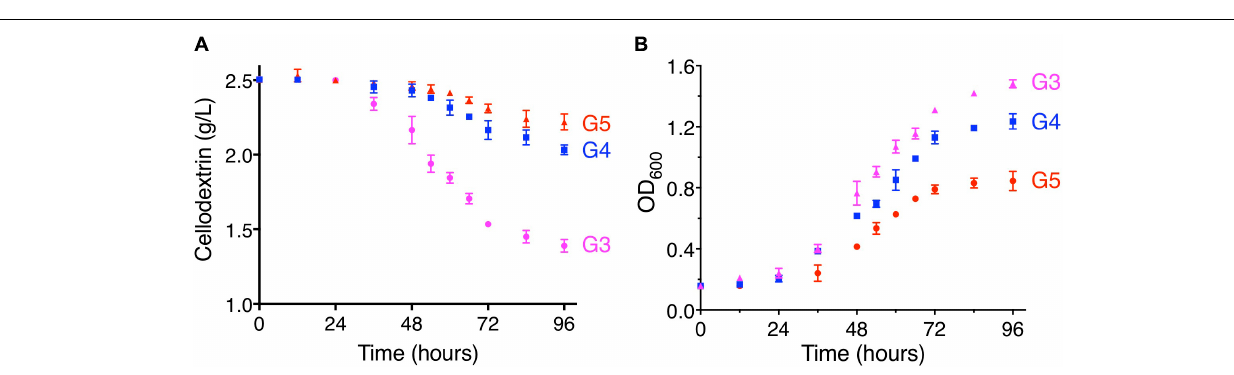
( Figure 5 ). The YP β G-CtA utilized 2.2 g/L cellobiose in 2